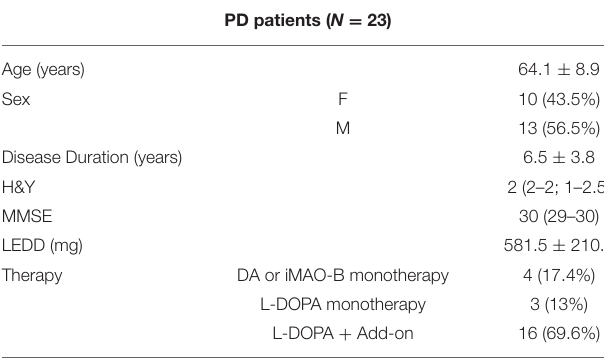
TABLE 1 | Demographic and clinical characteristics of enrolled